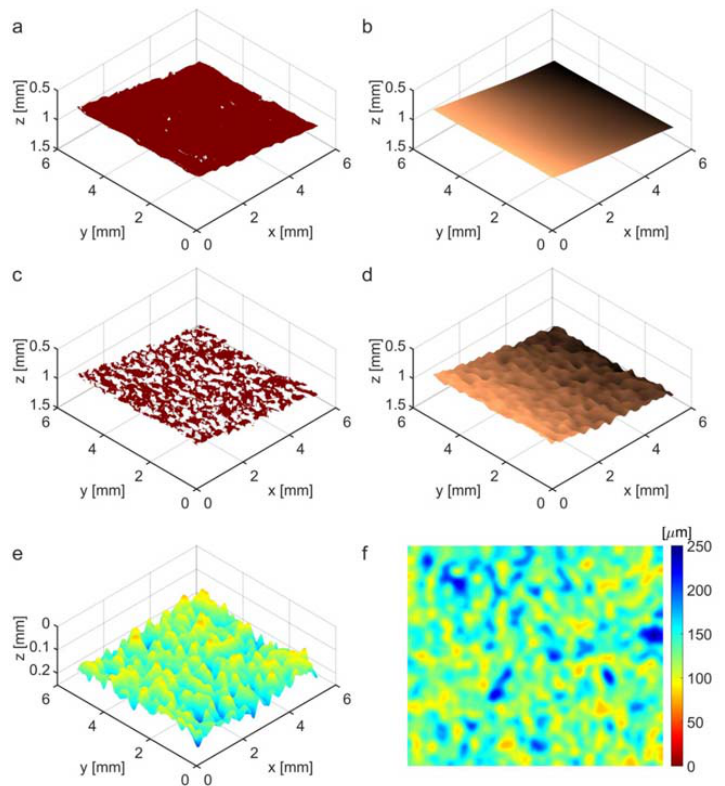
Figure 10. Illustration of selected stages in the Cordura image segmentation work-flow presented in Figure 9. ( a ) Cordura surface boundary; ( b ) Cordura surface approximated with fifth order polynomial; ( c ) pieces of the internal border of the polyurethane layer obtained after filtration (Figure 9 (6)) and thresholding (Figure 9 (7)); ( d ) polyurethane internal border approximated using the spline function; ( e ) thickness map of polyurethane cover lamina in 3D view; ( f ) flat coloured thickness map of the polyurethane cover layer.